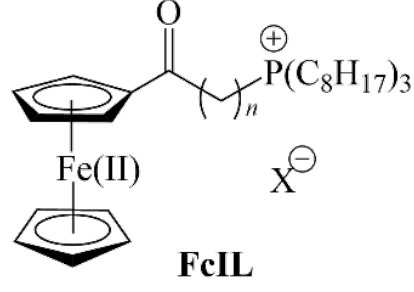
Figure 1. The structure of trioctyl(ferrocenylhexanoyl)phosphonium ionic liquid (FcIL) in which n = 5 and X − = B(C 6 F 5 ) 4 − (i.e., TB).